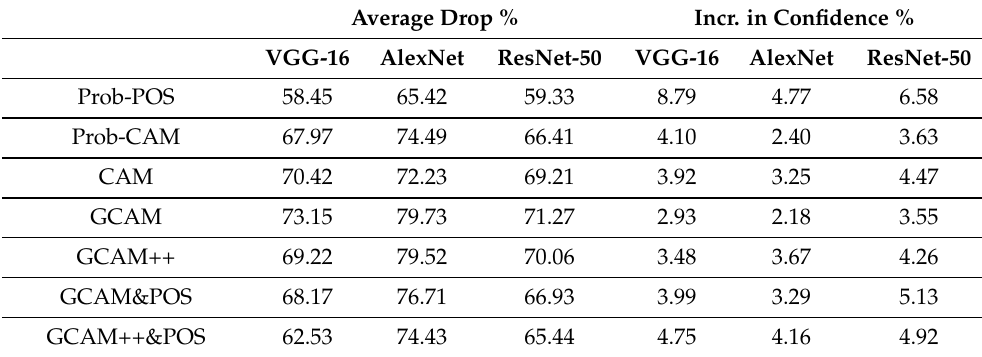
Table 8. Quantitative evaluation of faithfulness on